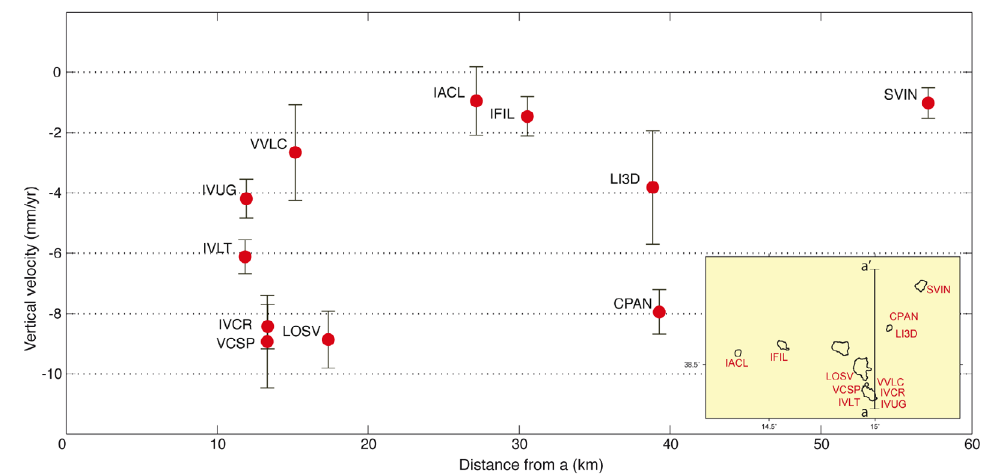
Figure 4. Geodetic vertical velocity for the Aeolian Islands from the CGPS